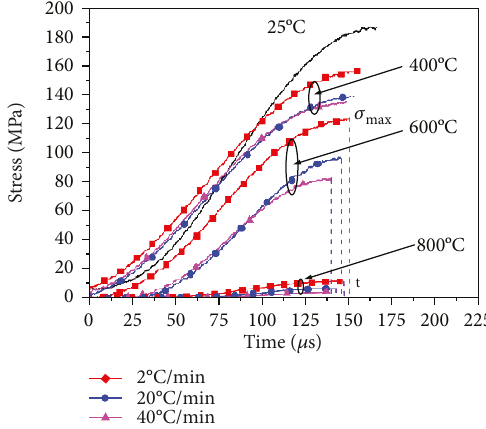
Figure 15: The correlation curve between the value of stress before the peak and time (note: σ max is the peak stress in the experimental